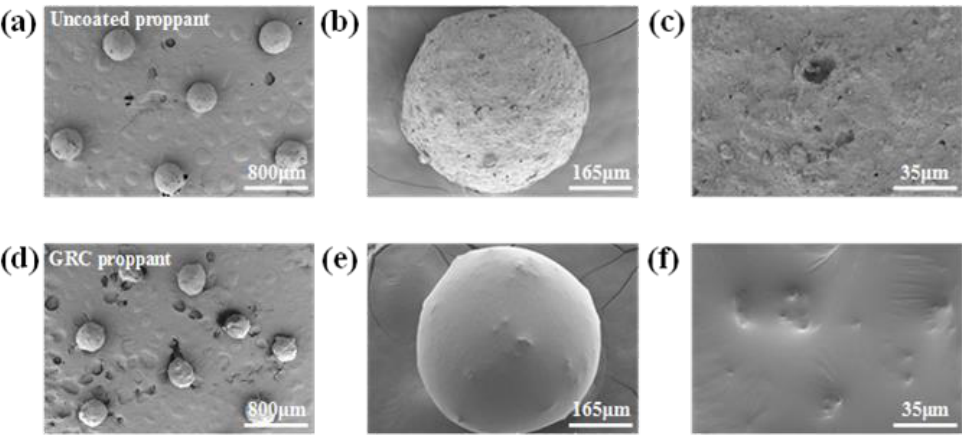
Figure 2. SEM images of uncoated ( a – c ) and GRC ( d – f ) proppants. The energy-dispersive X-ray spectroscopy (EDX) results of uncoated and GRC prop- pants are shown in Figure 3. The surface of the uncoated proppant contains a large num- ber of silicon and oxygen. After coating, silicon and oxygen are partly reduced and a large number of carbon and nitrogen elements are detected, indicating that the polymer coating covers the uncoated ceramic proppant well.